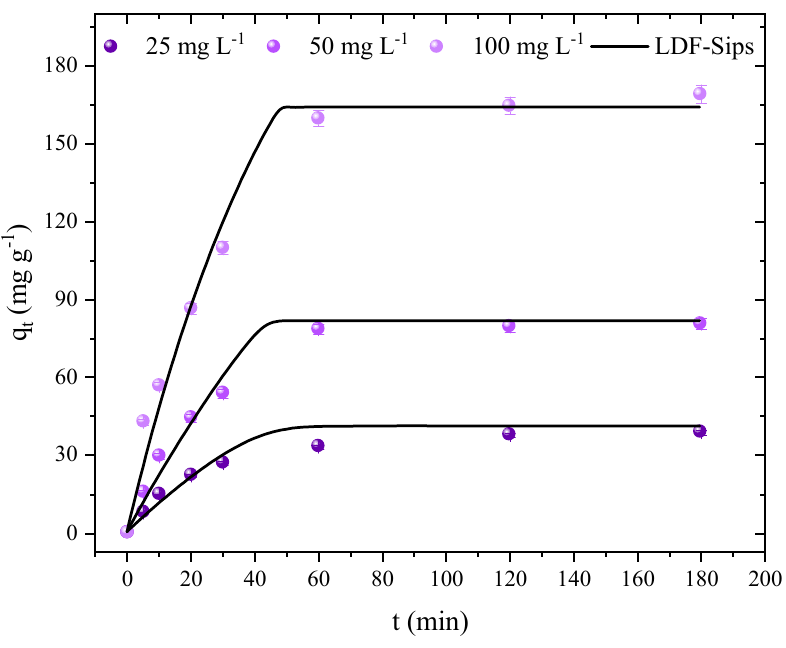
Figure 8. Adsorption capacity at any time (q t , mg g − 1 ), according to the sample collected; points represent the experimental data and lines the values predicted by the model for the 2,4-D/AC system (T = 298 K, adsorbent dosage = 0.6 g L − 1 , natural pH of the solution, V = 50 mL, and stirring rate = 180 rpm).